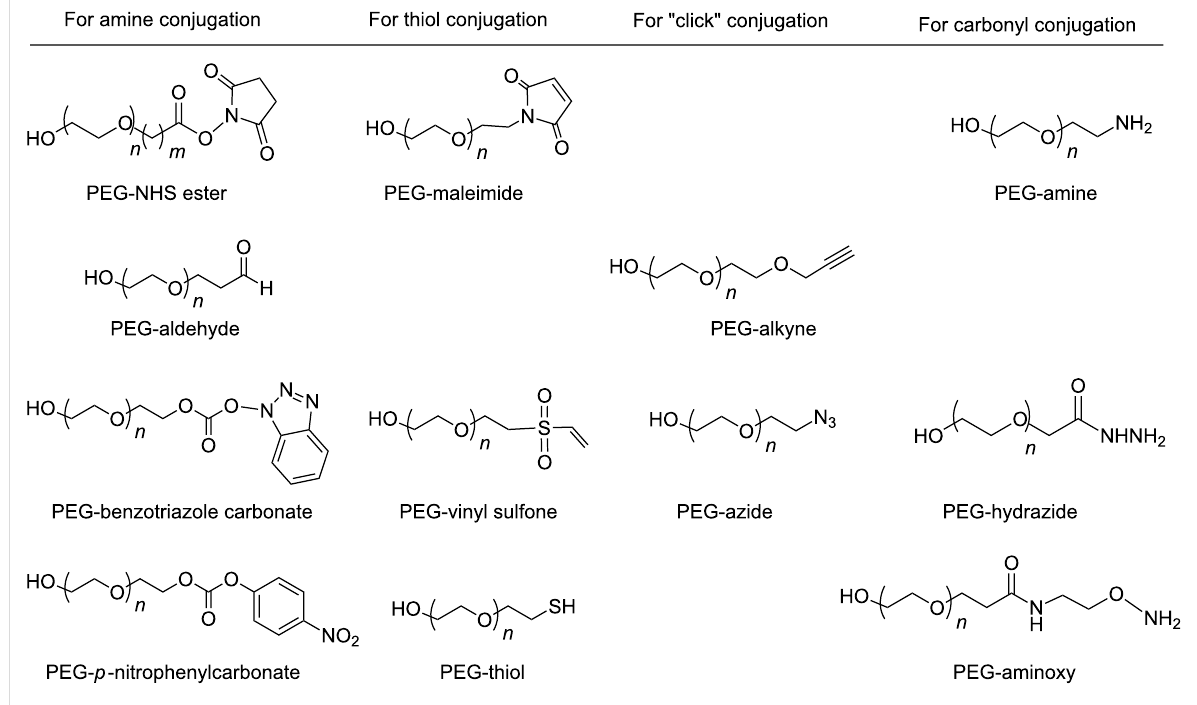
Figure 2: Activated PEG derivatives for conjugation.